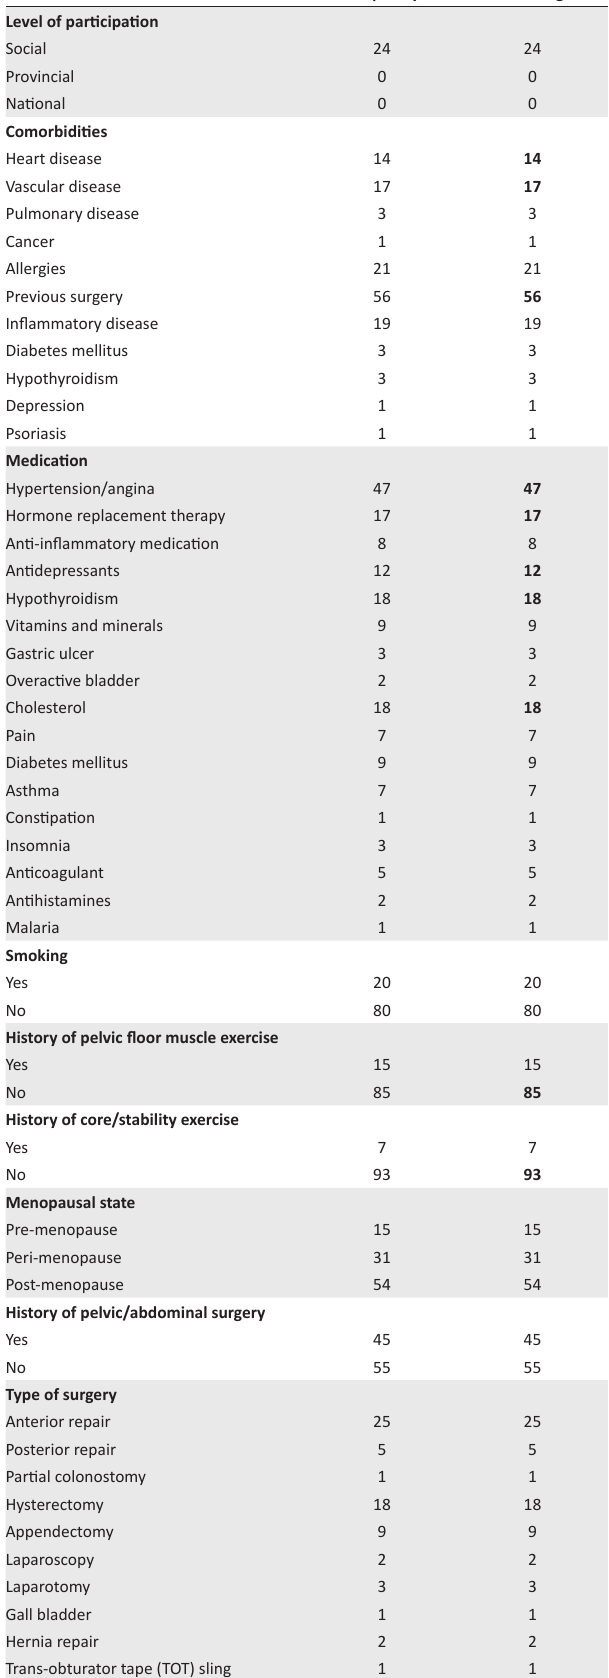
TABLE 3 (Continues...): Results for demographic variables (categorical), n =